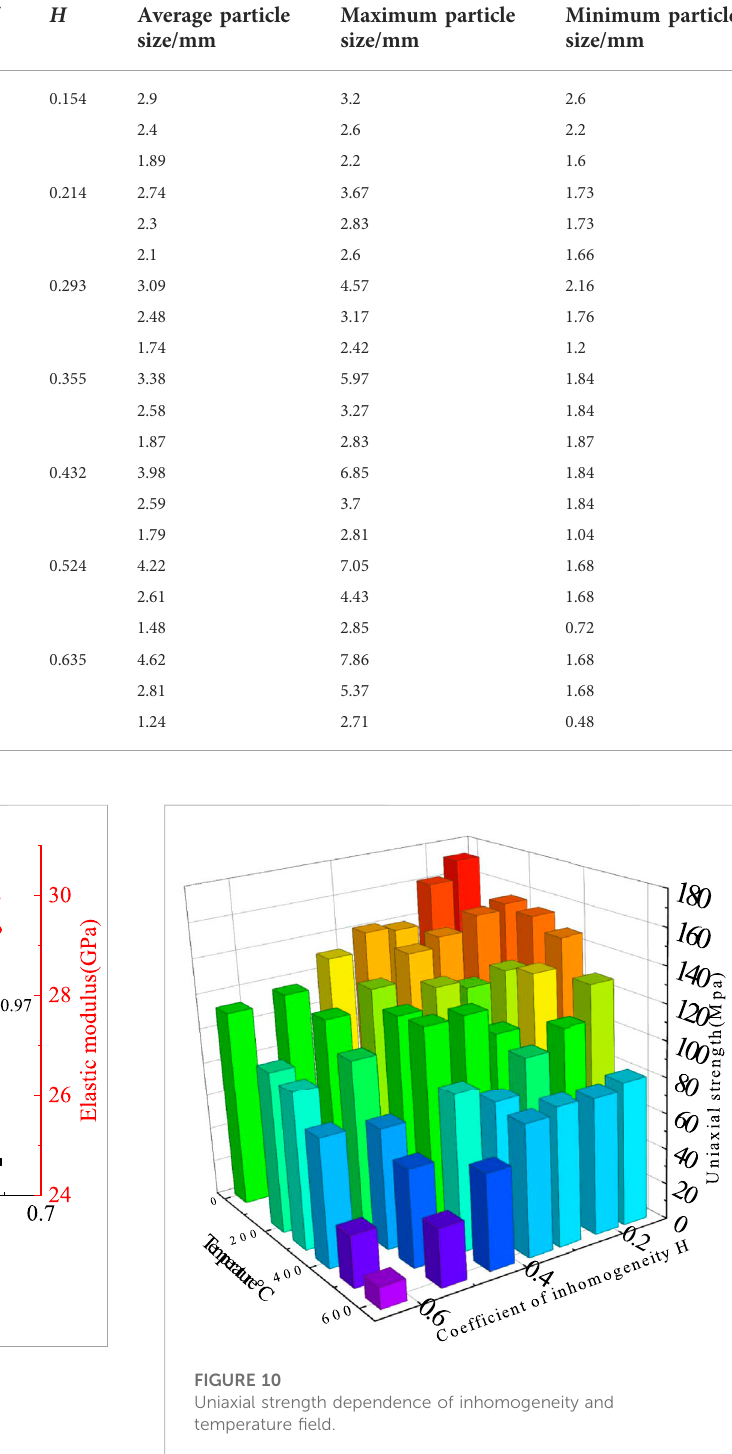
TABLE 5 Grain size distribution of crystals.